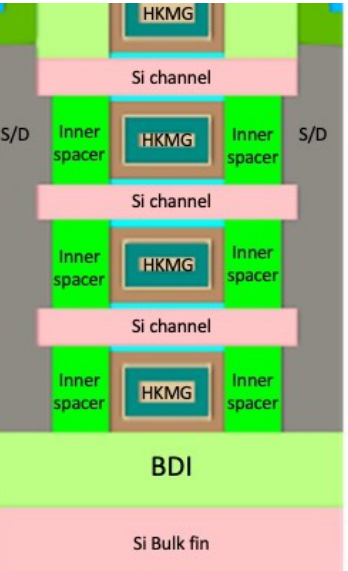
Figure 7. This figure shows a close up view of the S/D cross-section. The width of the high-k metal gate here is the gate length L g , and the vertical thickness of this metal gate is determined by T sus . Additionally, the inner spacers and bottom dielectric isolation are